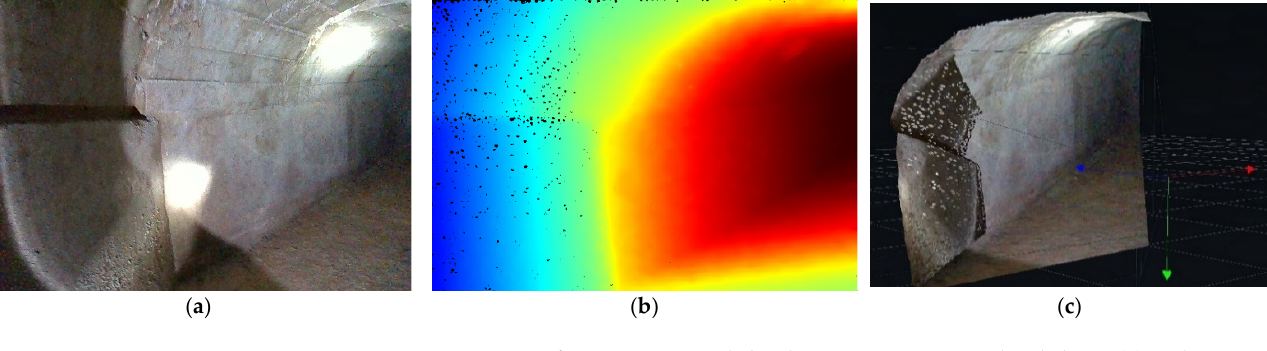
Figure 10. Conversion of RGB image and depth image into point cloud data. ( a ) Color image; ( b ) Depth image; ( c ) Point cloud.